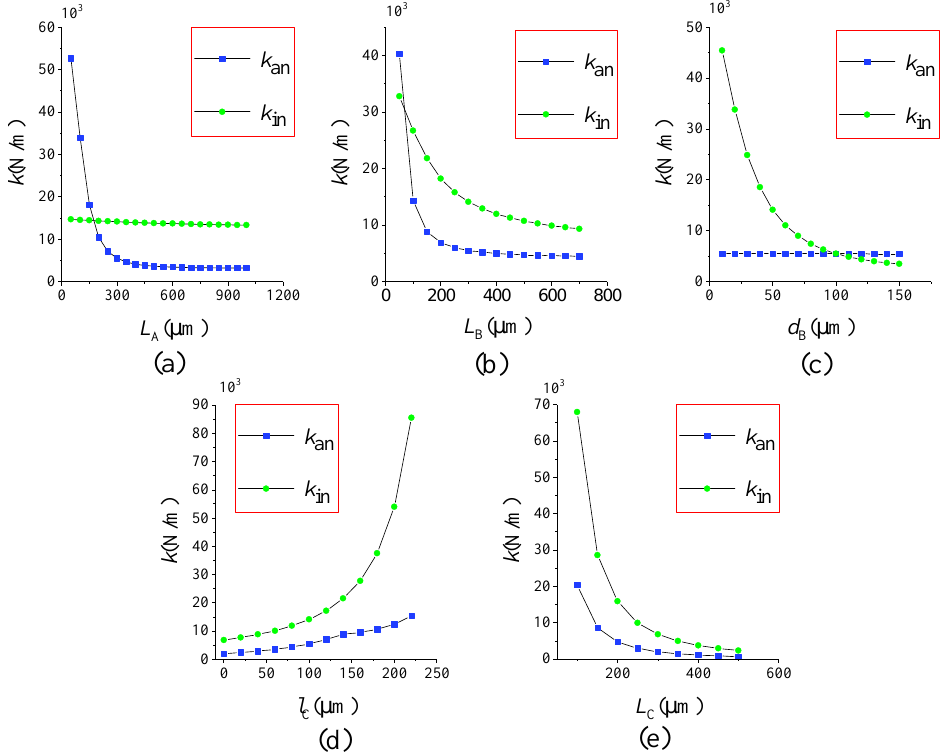
Figure 8. The relationships between the in-phase coupling stiffness, as well as the anti-phase coupling stiffness and: L A ( a ); L B ( b ); d B ( c ); l C ( d ); L C ( e